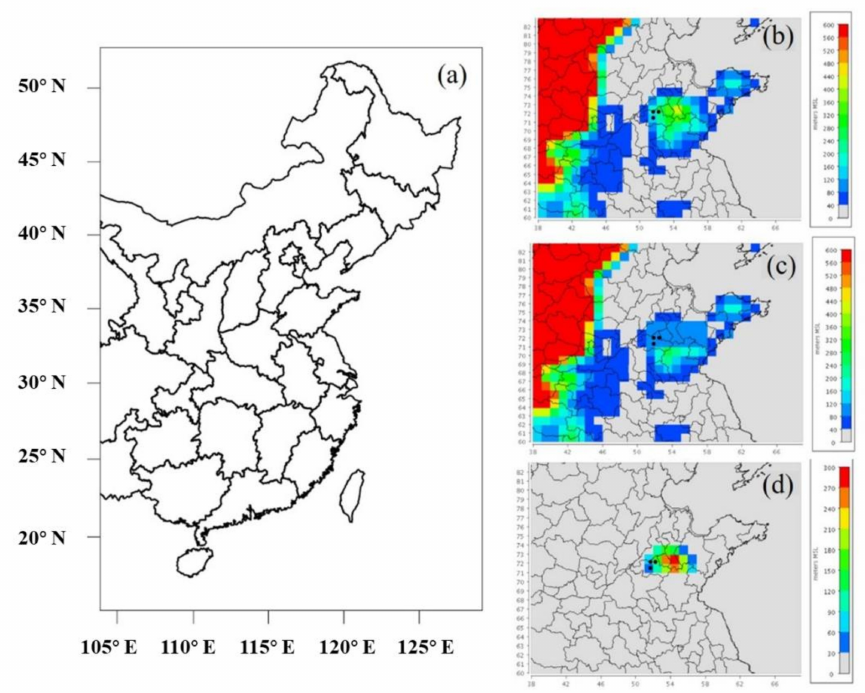
Figure 2. Map of ( a ) the model domain; ( b ) default terrain height (m); ( c ) modified terrain height (m); and ( d ) the terrain height difference between ( b ) and ( c ) in the